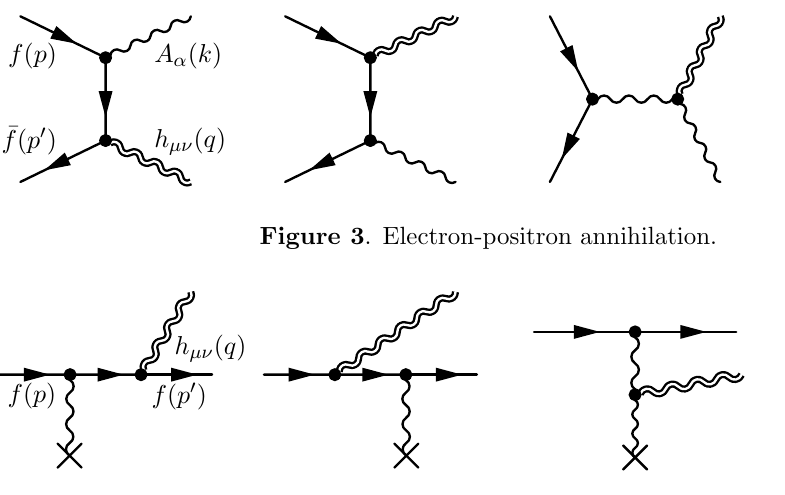
Figure 4 . Gravi-bremsstrahlung